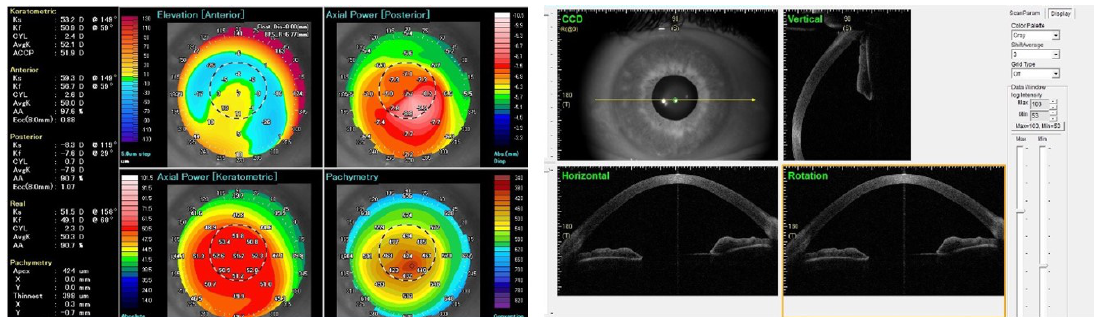
Figure 1. Representative case of a patient with keratoconus in which the two classifications were not consistent (the Amsler–Krumeich score higher than the Sandali one). The disease was classified as stage III according to the Amsler–Krumeich classification while as stage 1 according to the Sandali classification.